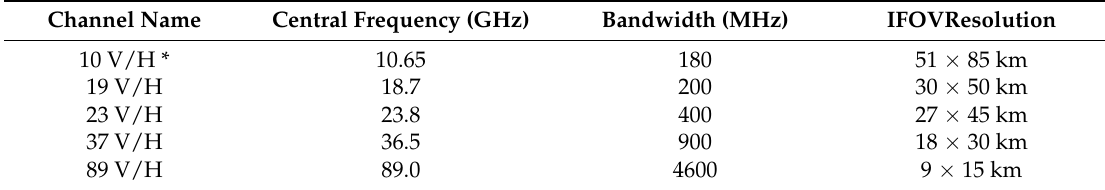
Table 1. Main parameters for FY-3C Microwave Radiation Imager